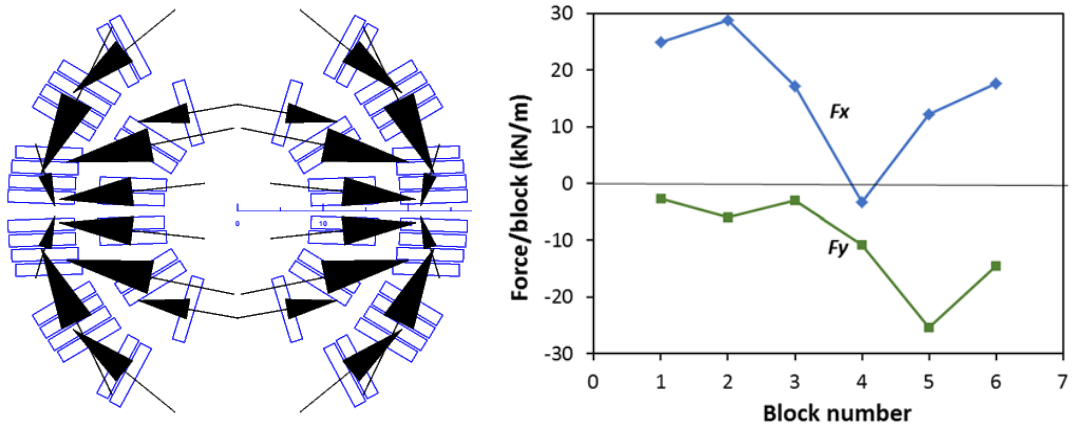
Figure 3. Lorentz force vectors in coil blocks ( left ) and Fx and Fy values per block for the blocks in the first quadrant ( right ) at a coil current of 6 kA. Block numbers are shown in Figure 1.